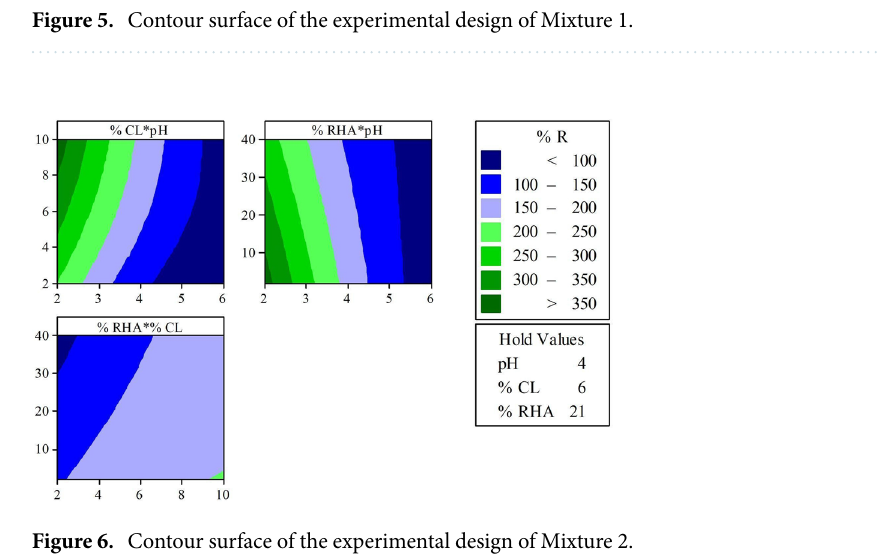
Figure 6. Contour surface of the experimental design of Mixture 2.